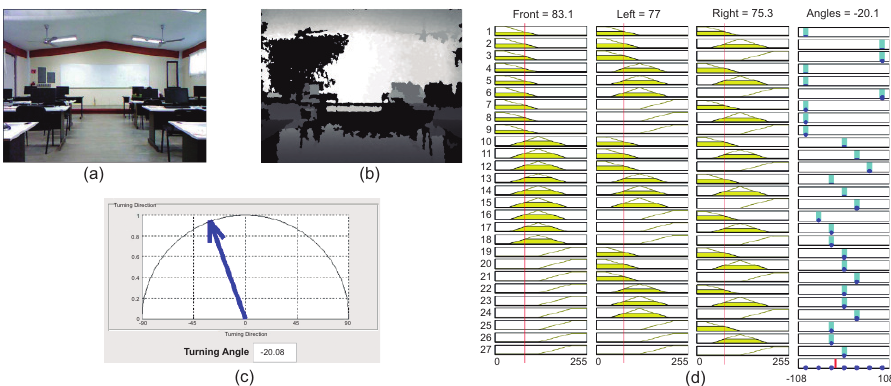
Figure 11. Examples of operation by using Era-Mobi: ( a – d ) simple path.